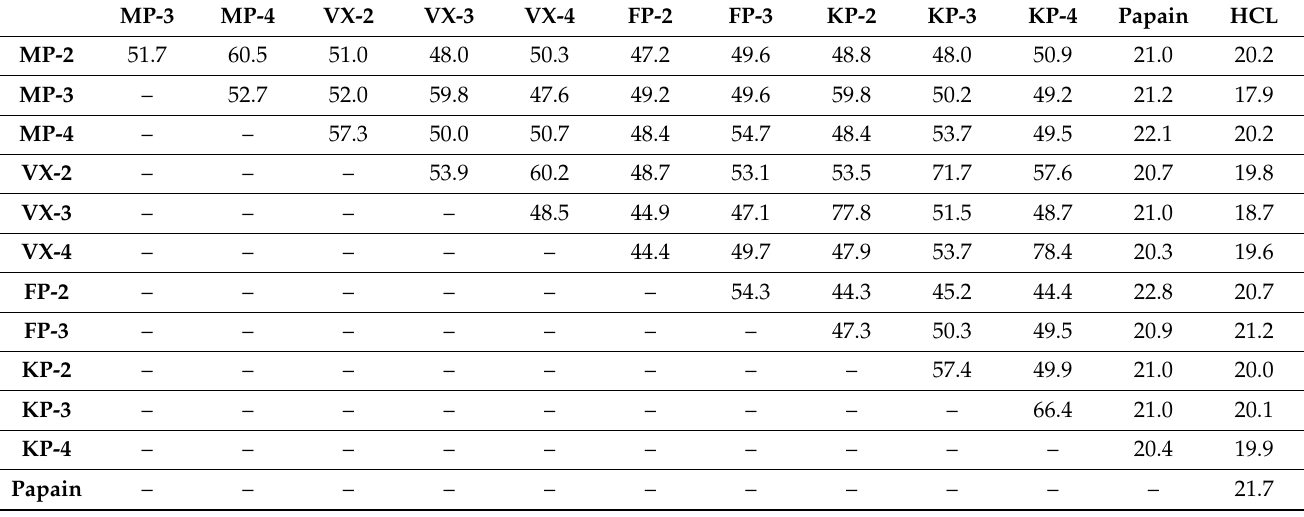
Table 1. Sequence identity between different cysteine proteases.